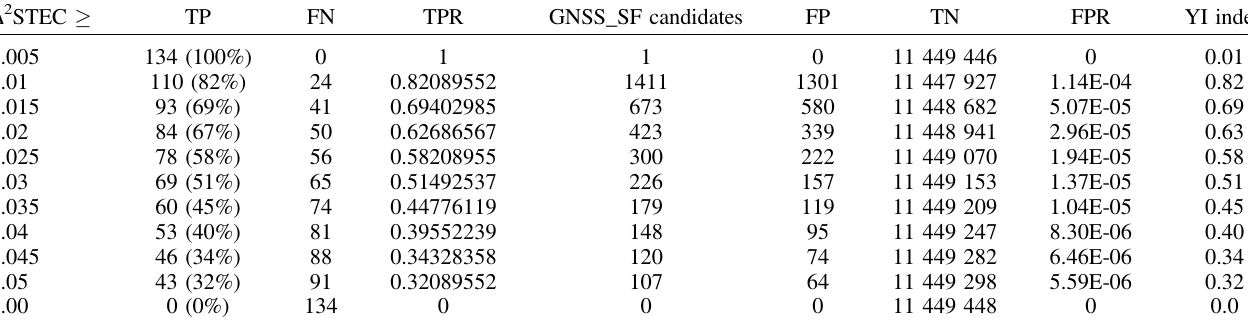
Table 3. Contingency table for several threshold values of the D 2 STEC parameter.